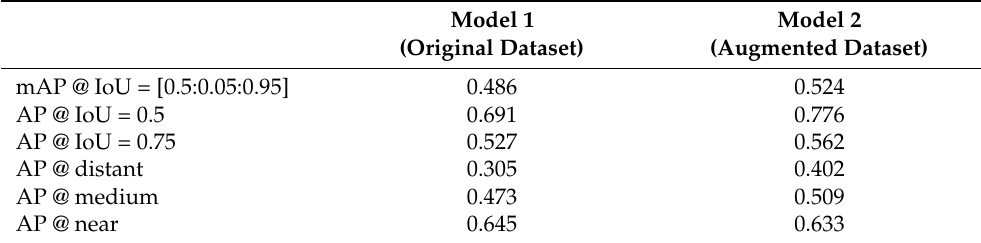
Table 2. Evaluation results.